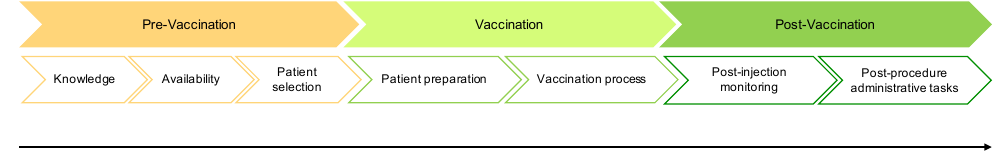
Figure 2. Phases of the vaccination process and related activities (based on